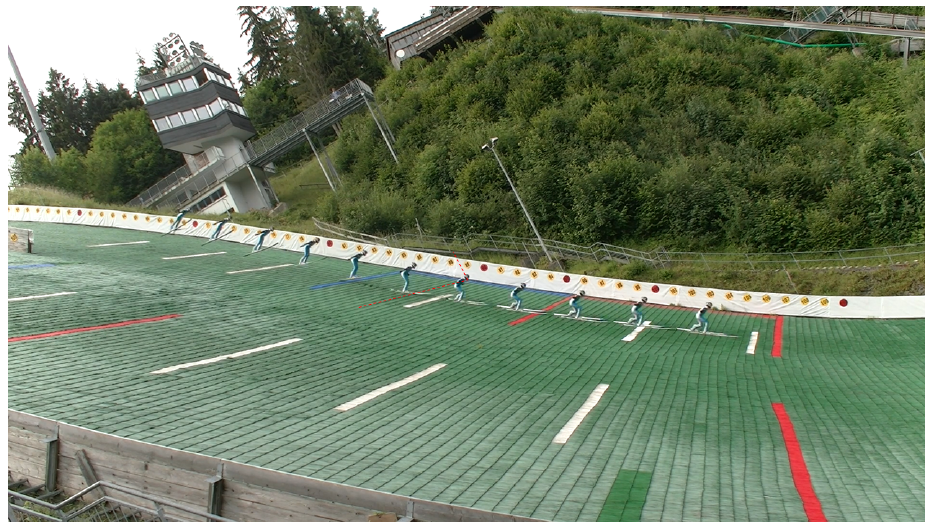
Figure A2. A picture of overlaid snapshots from video recordings to illustrate the jump length detection from video